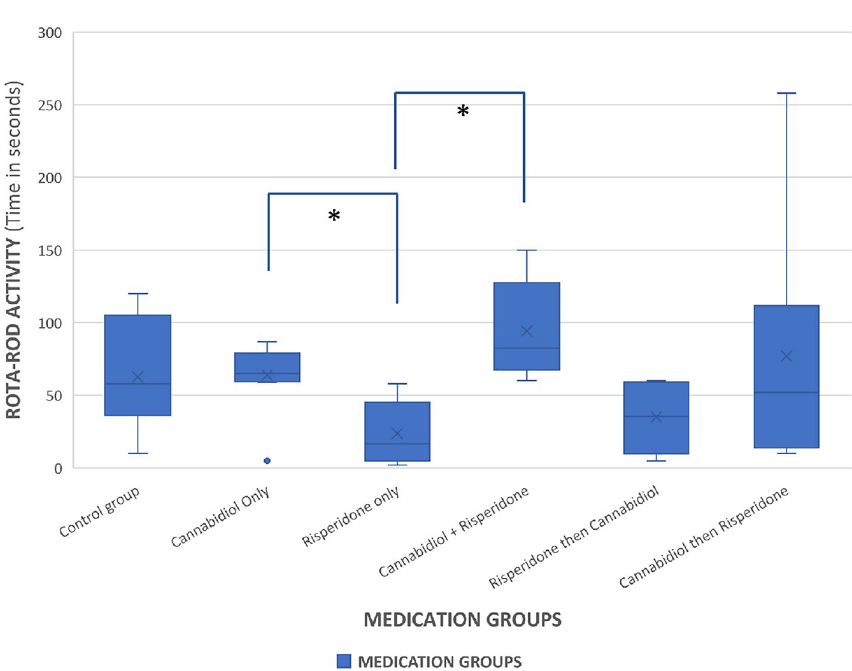
Figure 3. Inter-group comparison of the observed time spent on the treadmill in each group during the Rota-rod experiment. There was increase in time spent on the treadmill in Group B compared to the rest of the groups. *Statistically significant